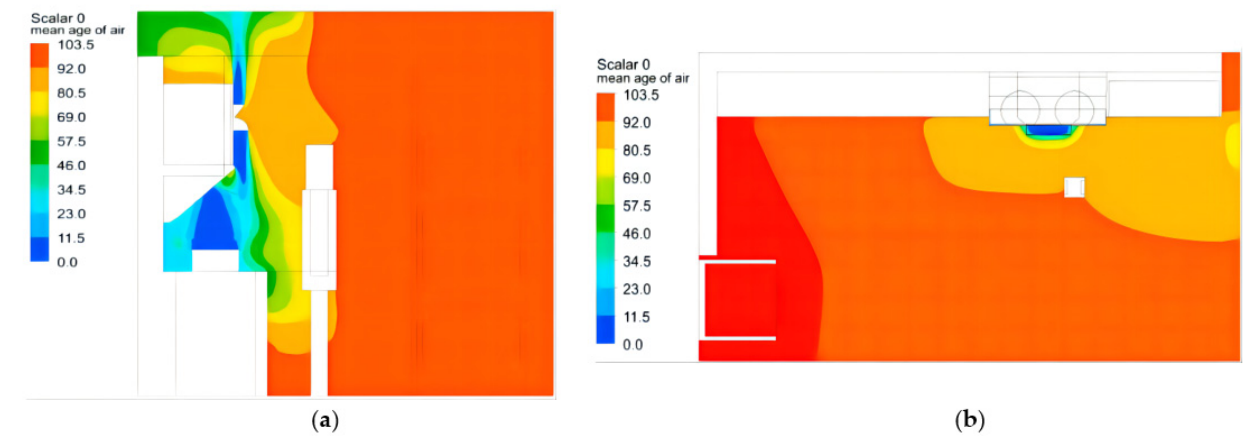
Figure 11. Fresh air on (90 s): ( a ) Air age distribution in the working area at z = − 2.62 m; ( b ) Air age distribution in the human breathing zone at y = 1.547 m.